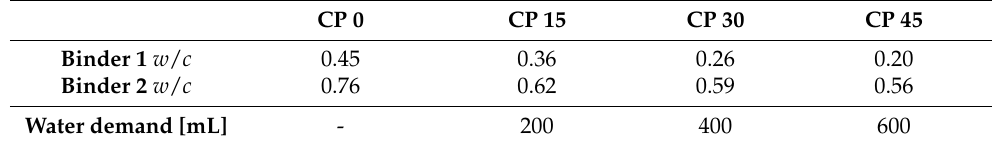
Table 4. Recalculated w/c for each CP level and theoretical water demand of increasing biomass